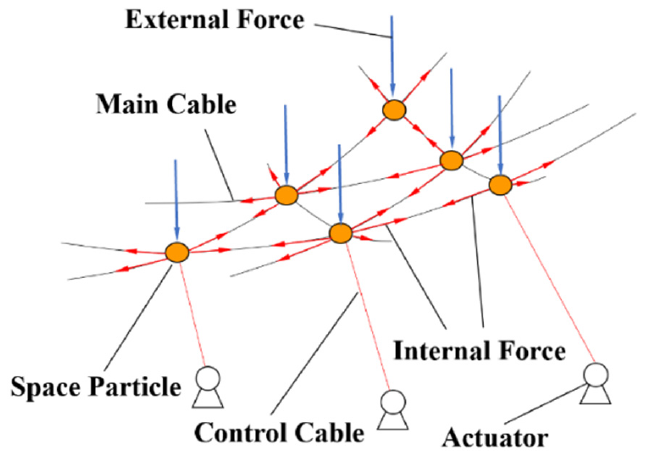
Figure 3. Discretization of the active reflector cable-net structure. The internal forces originate from the deformation of the element that is determined by the change of the relative position of space particles and are related to the element material and section. The external forces include the forces acting directly and indirectly on the space particles, where the latter refers to the equivalent forces acting on the elements. The time history is divided into a finite number of tiny time steps, ∆ t. The super- position of the motion on each micro-segment is used to describe the overall trajectory of space particles, which approximates the continuous motion of the structure in space and time. It is assumed that the entire analysis time history is [ t 0 , t f ]. Furthermore, a series of time points t 0 , . . . , t a , t b , t c , . . . , t f are used to divide the total time into a certain number of periods. If the motion of a space particle in a certain period [ t a , t b ] satisfies the standard governing equation, the calculation trajectory of the space particle in this period is denoted as the path element, as shown in Figure 4. The structural behavior remains continuous within the path element. Material properties and the stress states of the space particles are regarded as constant values, and the motion of the space particles is approximately regarded as linear. If the period of a path element is small enough, strain and stress increments of the element are considered very small. Thus, the problem of large displacement and large deformation can be simplified to the problem of large displacement and small strain. Therefore, the internal force calculation of some discontinuous structural behaviors can be